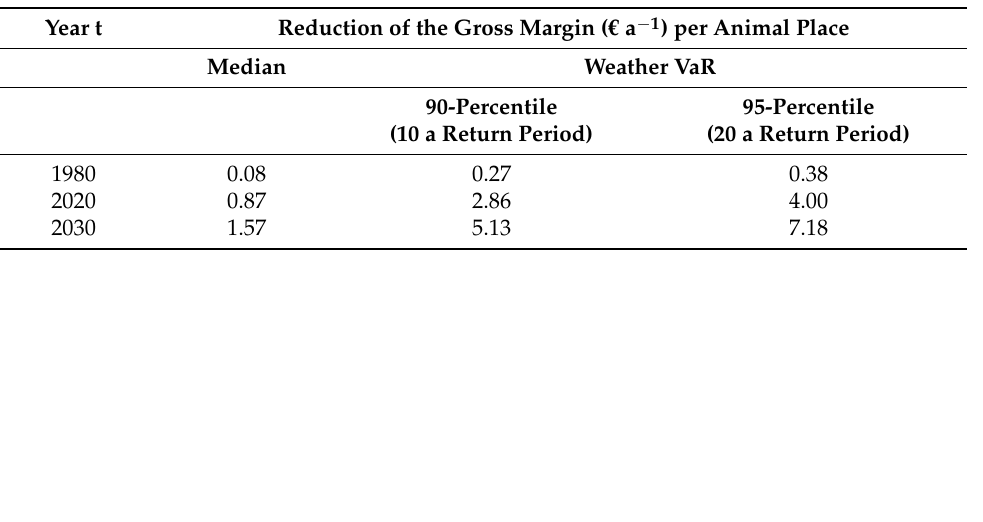
Table 7. Statistics of economic risk by the reduction of the gross margin ( € a − 1 ) per animal place for t = 1980, t = 2020, and t = 2030. The weather-VaR values were calculated for a 90 and 95-percentile, corresponding to a return period of 10 a and 20 a,